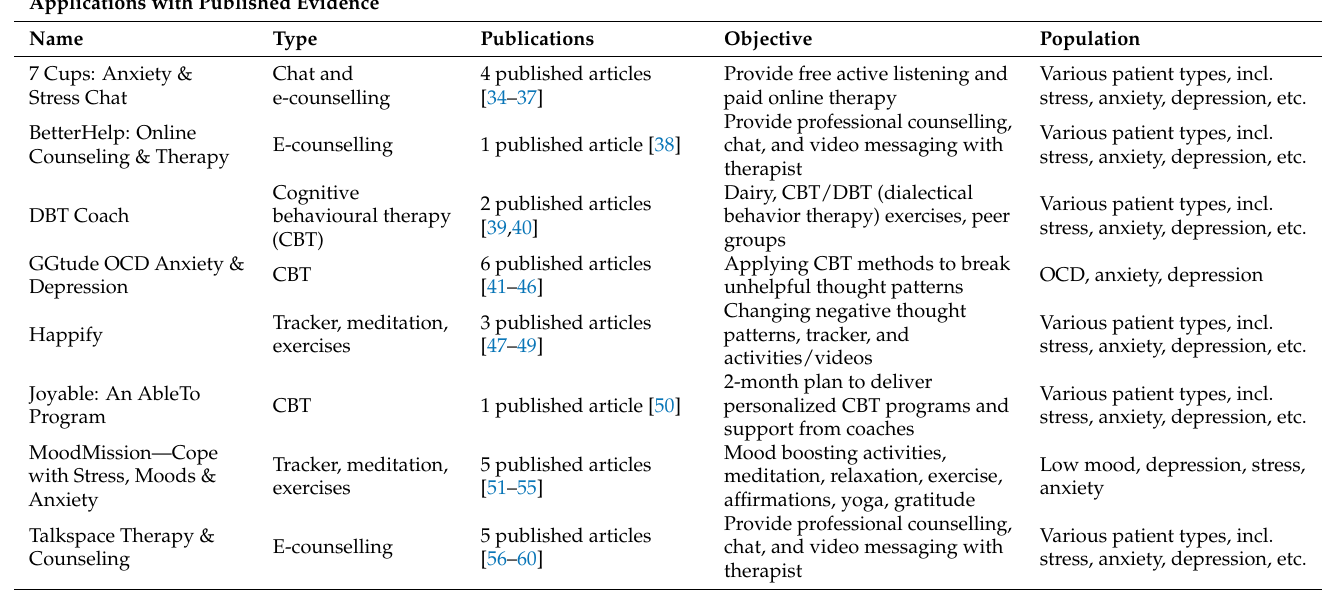
Table 2. Resulting apps possessing available published evidence.